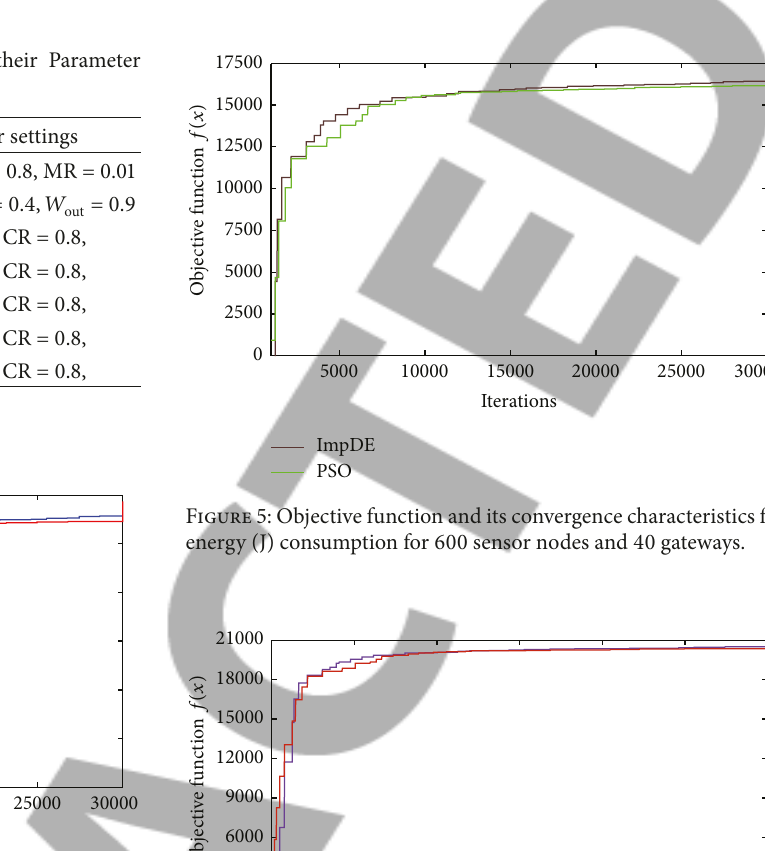
Figure 3: Objective function and its convergence characteristics for energy (J) consumption for 200 sensor nodes and 10 gateways.